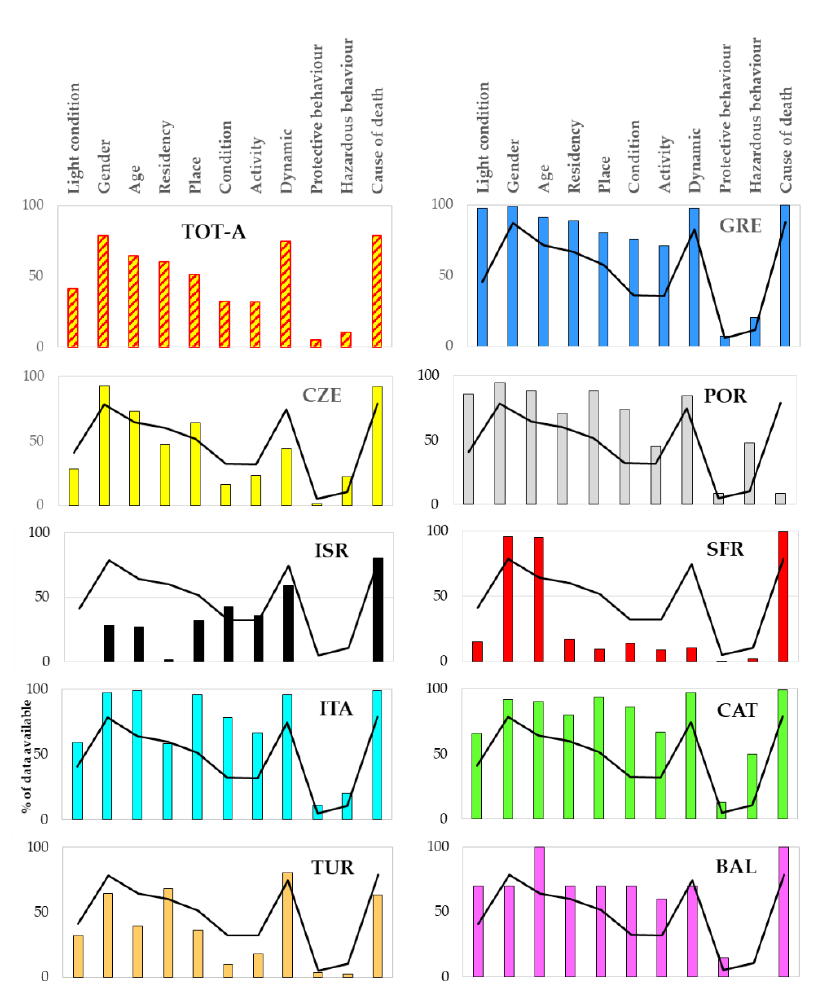
Figure 10. Percentage of data available for each variable in TOT-A, and in each SA.